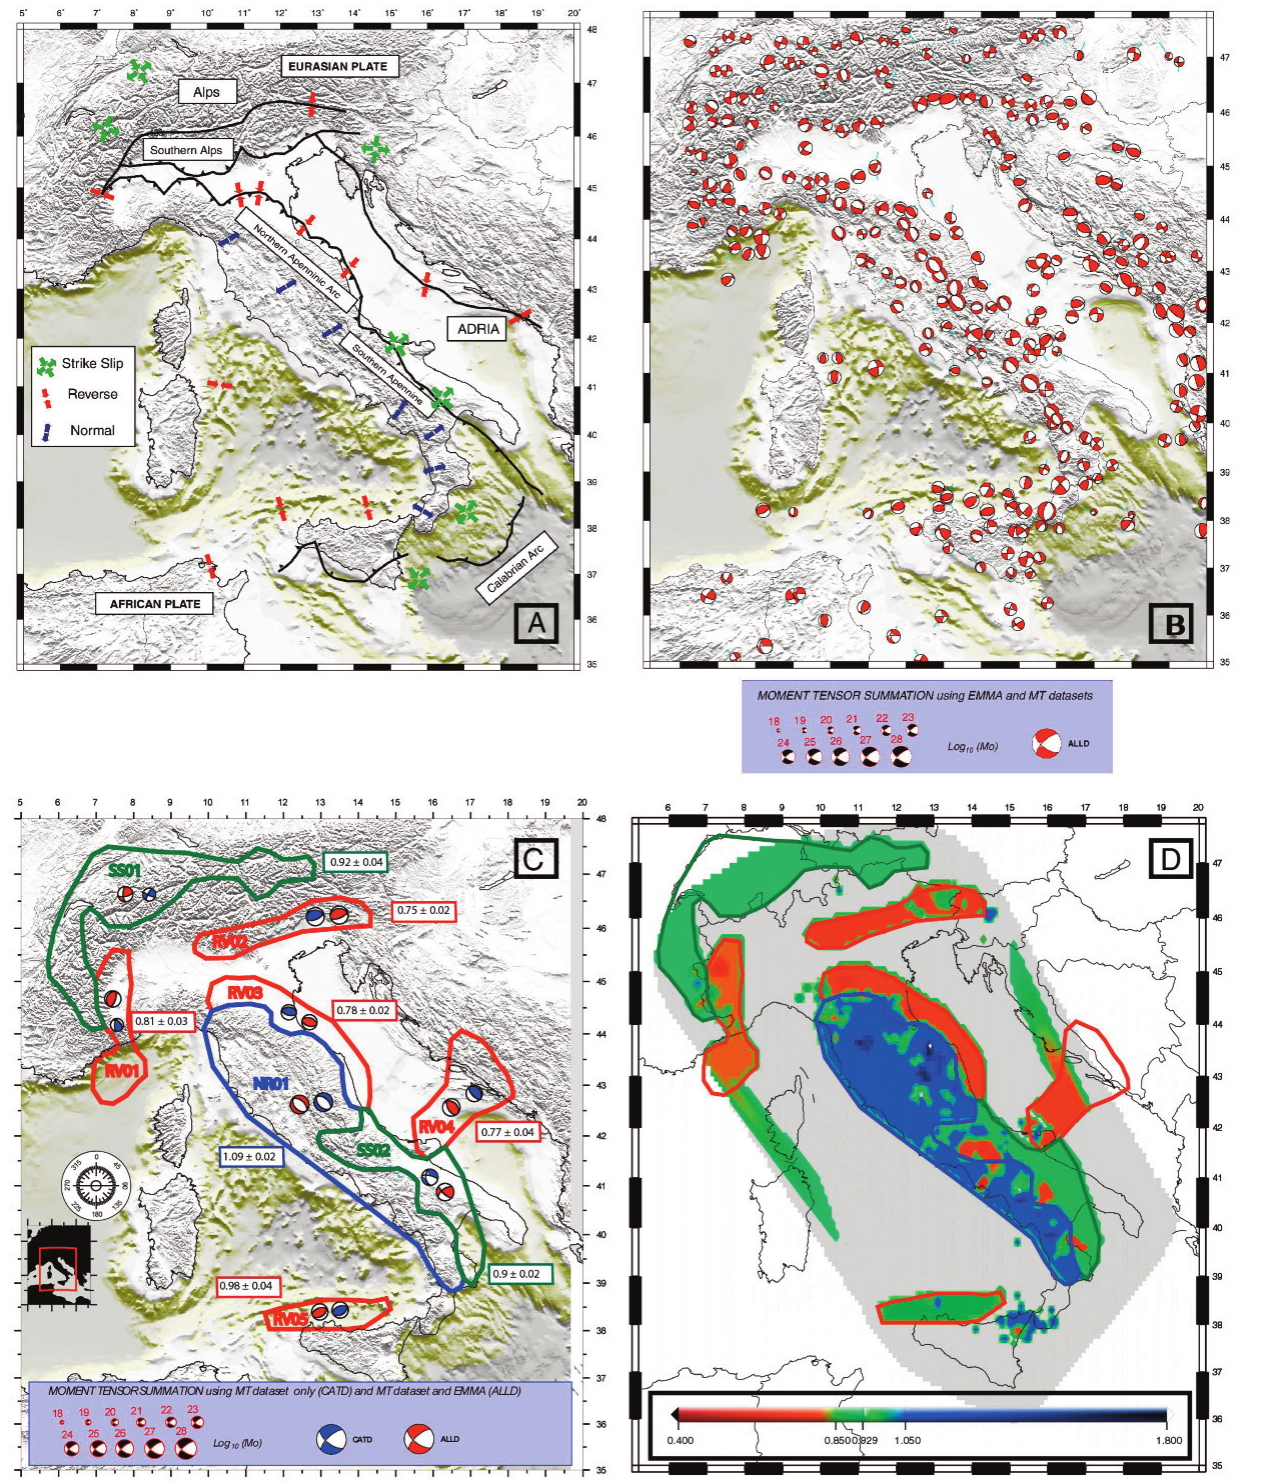
Figure 3. A) Structural model of Italy with the directions of the inferred regional stress regimes (from Montone et al. 2004). Red arrows, compressional; blue arrows, extensional; green arrows, strike-slip. B) Sum of the moment tensors on a grid with a mesh of one degree for earthquakes with depths ≤ 35 km (elaboration by Gianfranco Vannucci), using the moment tensor and the EMMA [Vannucci and Gasperini 2003, Vannucci and Gasperini 2004] dataset. C) Tectonic zonation with relative b -values and moment tensor summation (from Gulia and Wiemer 2010). D) The HALM-based b -value map and seismotectonic